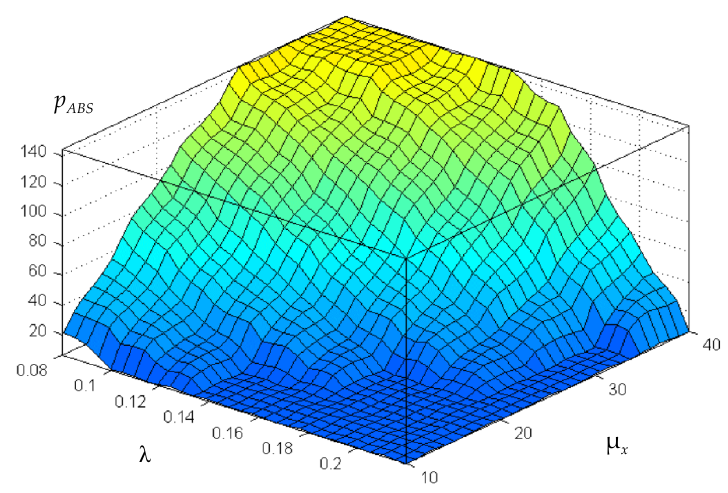
Figure 6. ABS FLC rule surface for the front wheels.